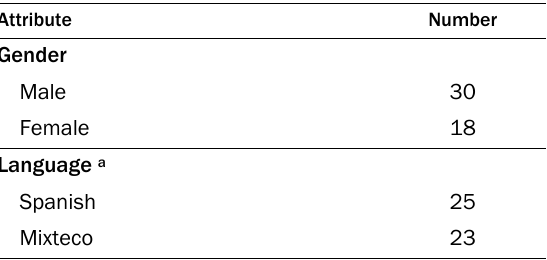
Table 1. Select Attributes of the Fresno Cohort